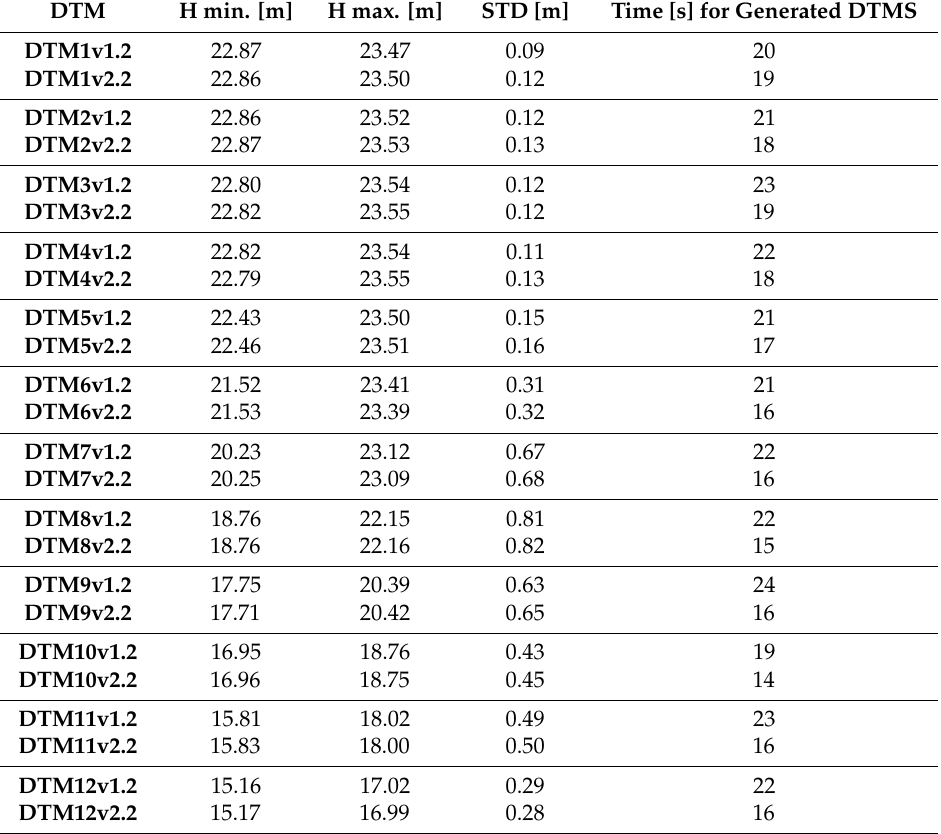
Figure 14. Isolines3v1.2 and DTM3v1.2, and isolines3v2.2 and DTM3v2.2 generated for strip 3 (po 3 ) by methodologies v1.2 and v2.2, respectively. Table 4. StatisticalcharacteristicsforDTMmv1.2andDTMmv2.2. (Where: